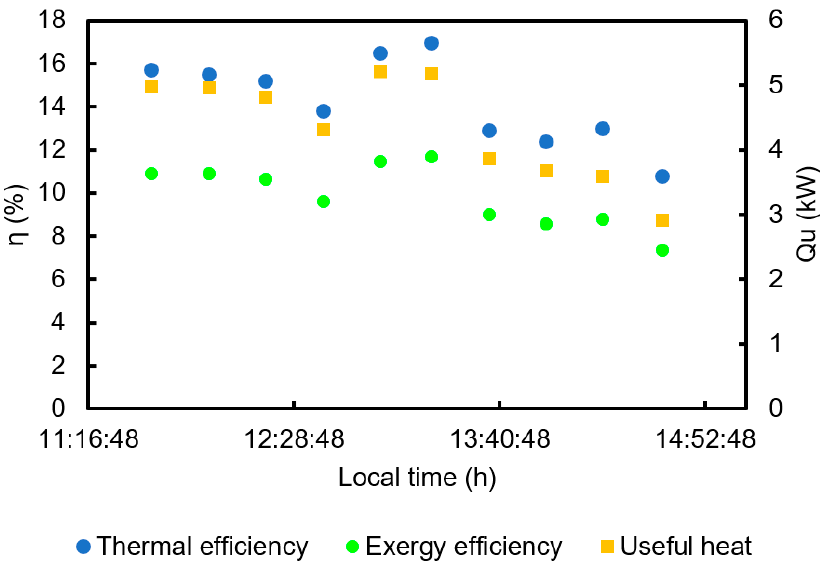
Figure 7. Thermal efficiency, exergy efficiency, and useful heat, 29 November 2017.